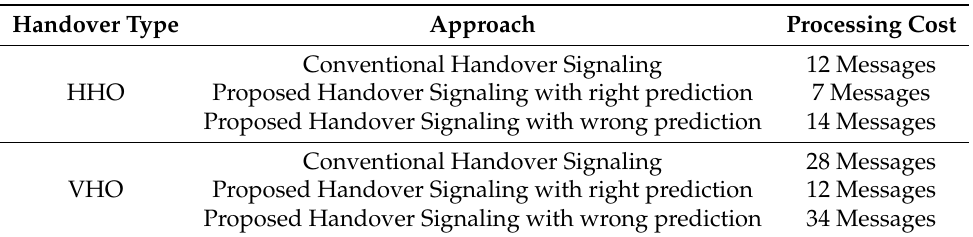
Table 5. Handover Processing cost for non-predictive and predictive scenarios when we use horizon- tal HO (HHO) and vertical HO